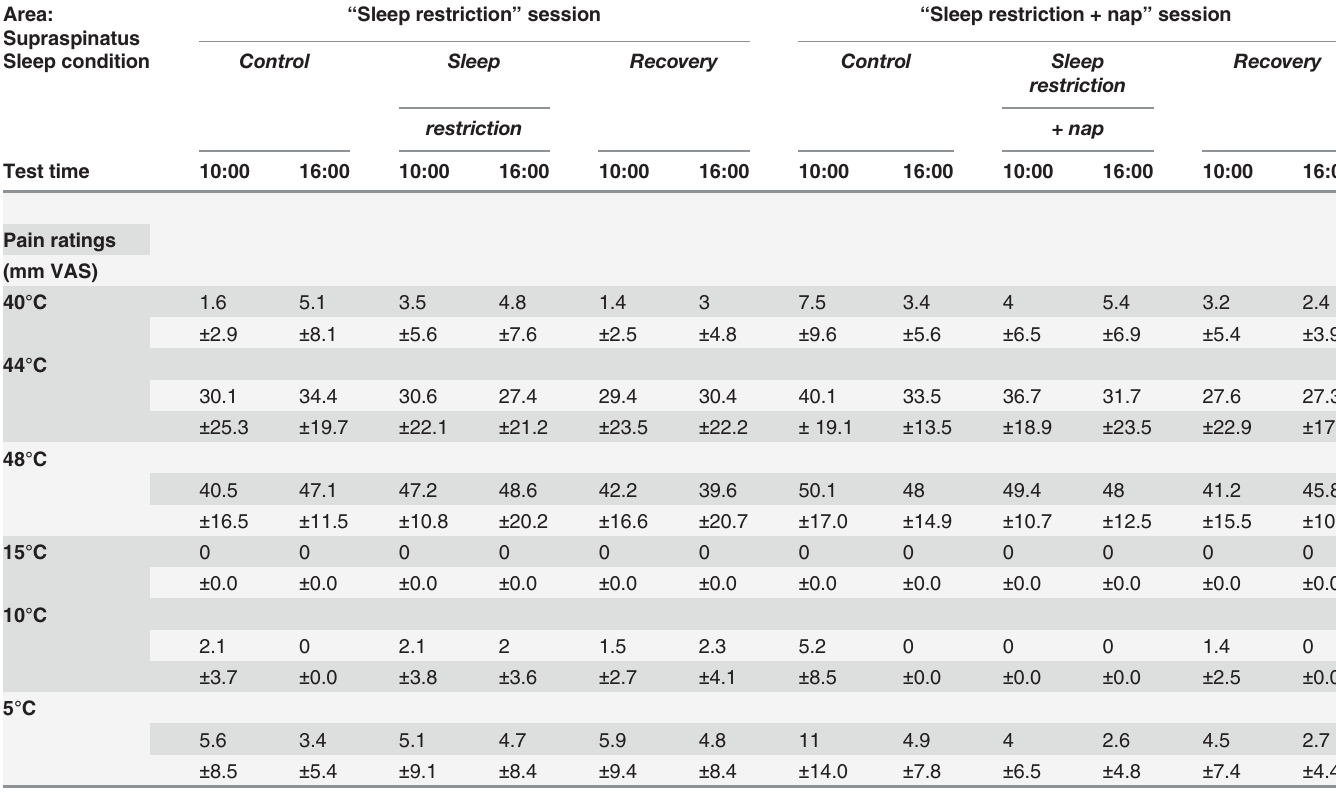
Table 3. Supraliminal thermal stimulation in supraspinatus area after sleep restriction without or with napping. Area: “ Sleep restriction ” session “ Sleep restriction + nap ” session Supraspinatus Sleep condition Control Sleep Recovery Control Sleep